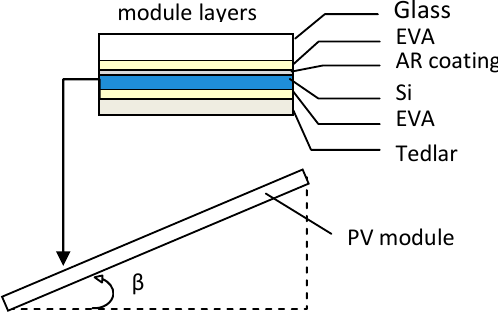
Figure 1. A schematic section of a photovoltaic (PV) module with its characteristic layers. EVA: Ethylene-vinyl Acetate, ARC: Anti-reflective Coating.